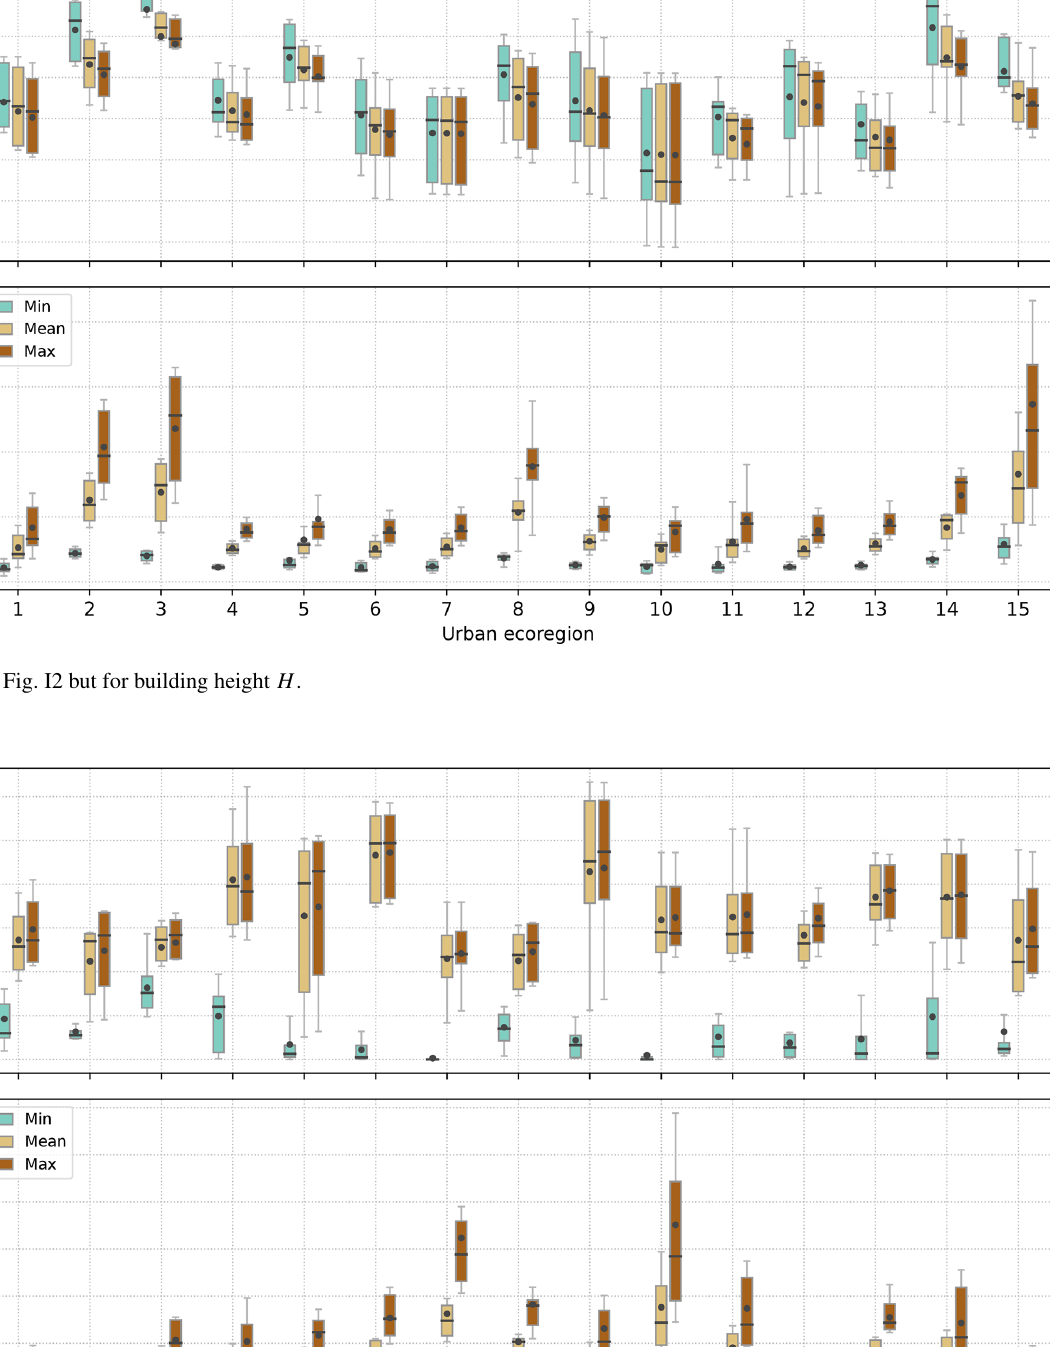
Earth Syst. Sci. Data, 14, 3835–3873,